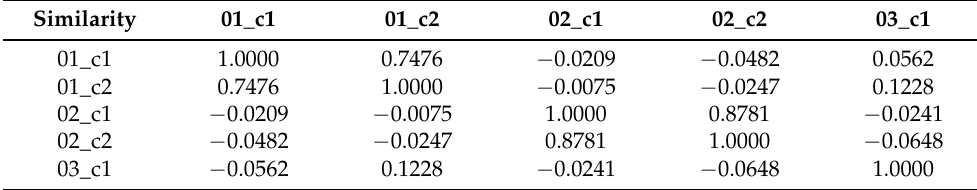
Table 1. The similarity between different